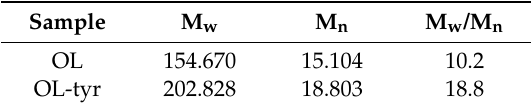
Table 2. M w , M n , and M w /M n of OL tyr compared with the parent OL a . Sample M w